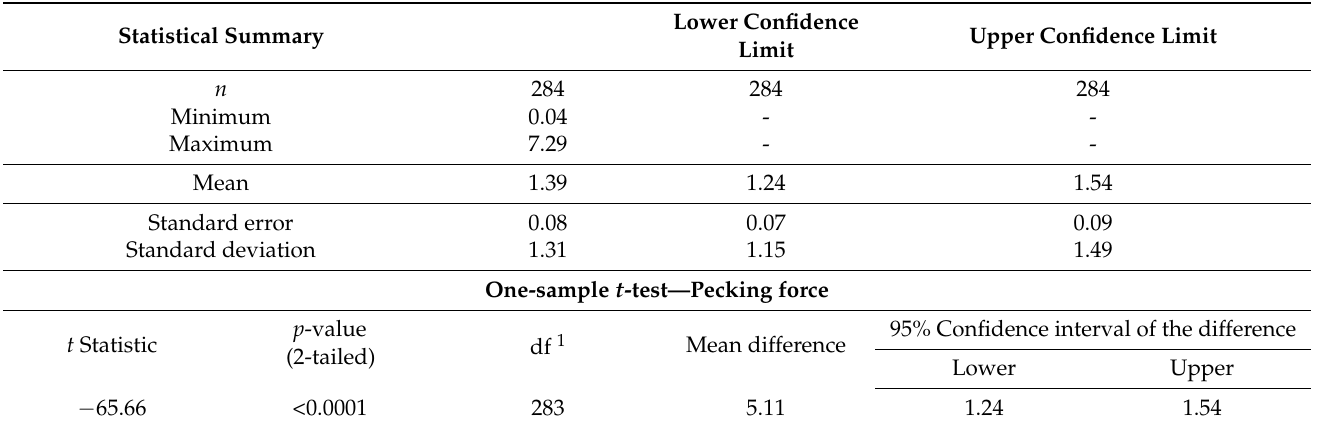
Table 1. Summary of results of descriptive analysis and t -test of broilers’ pecking